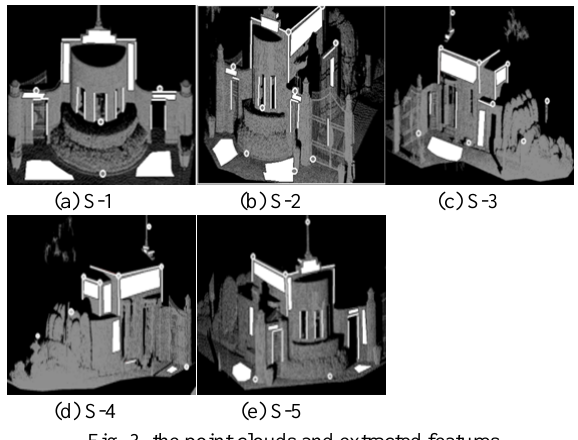
Fig. 3. the point clouds and extracted